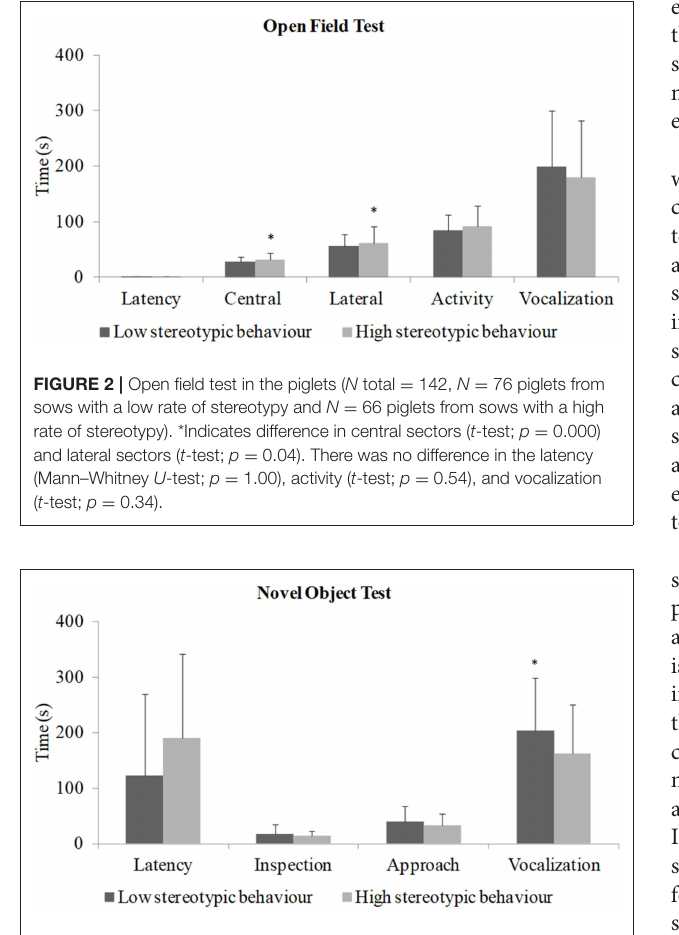
FIGURE 3 | Novel object test ( N total = 142; N = 76 piglets from sows with a low rate of stereotypy and N = 66 piglets from sows with a high rate of stereotypy) *Indicates difference on vocalization ( t -test; p = 0.008). There is no difference on latency (Mann–Whitney U -test; p = 0.17),